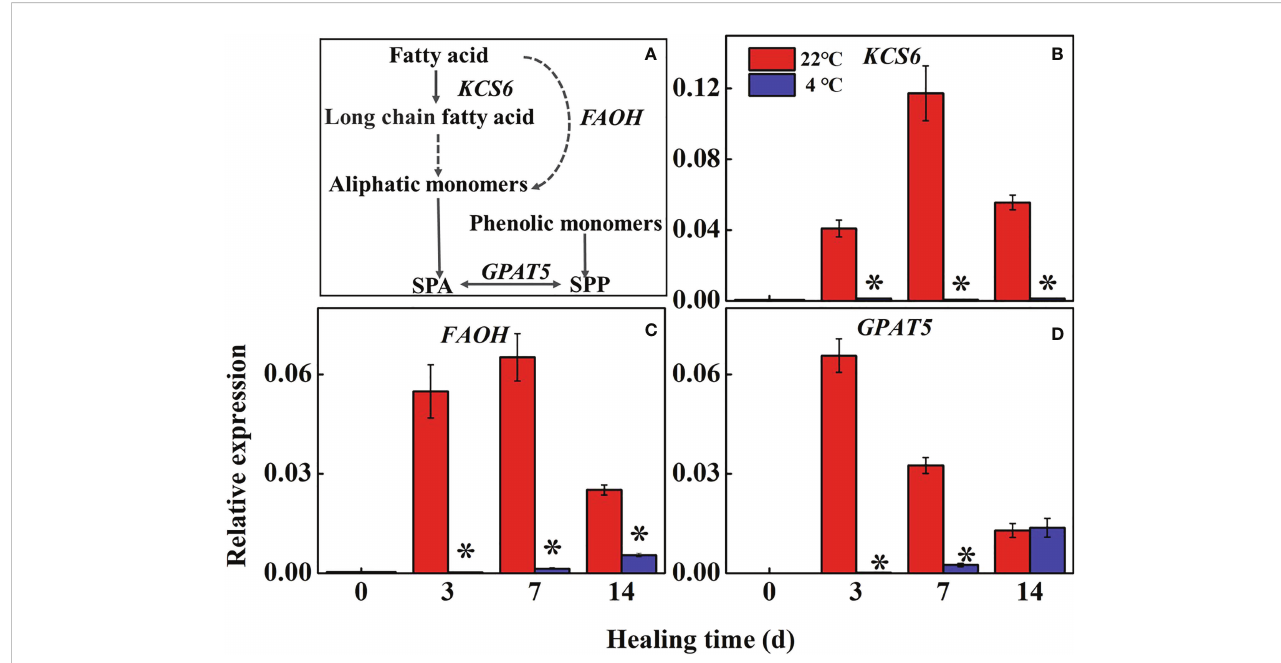
FIGURE 3 (A) The pathway of fatty acid metabolism and effects of different temperatures on the expression of (B) 3- Ketoacyl-CoA synthase (KCS6) , (C) fatty acid- hydroxylase (FAOH) , and (D) glycerol-3-phosphate acyltransferase (GPAT5) at the wound sites of potato tubers during healing. The symbol (*) indicates signi fi cant differences among different treatments at p <